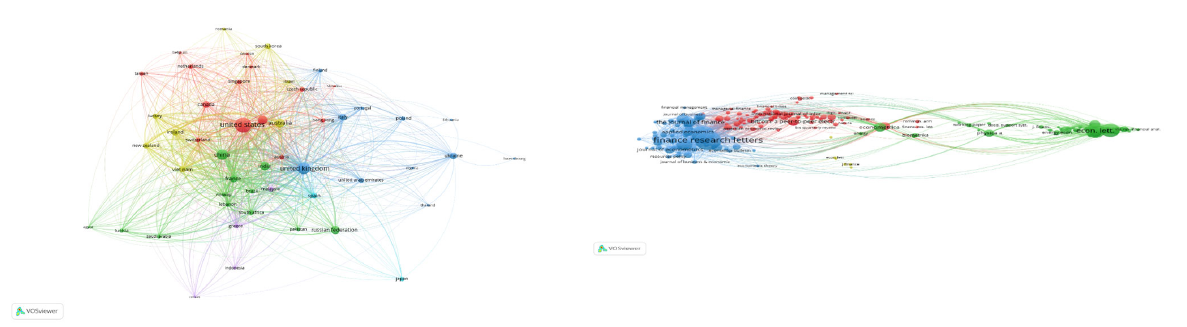
Fig. 5. Co-citation between countries Fig. 6. Co-citations of sources